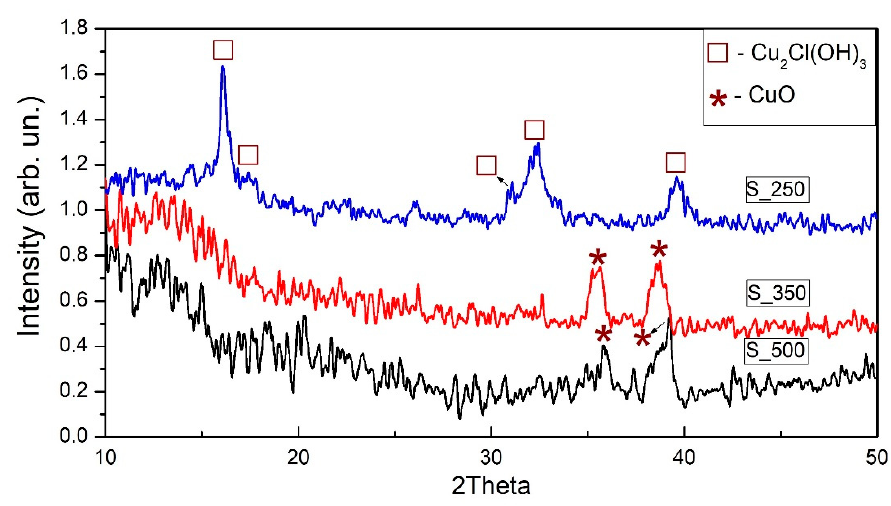
Figure 2. XRD patterns of the films annealed at di ff erent Figure 2 . XRD patterns of the films annealed at different temperatures.